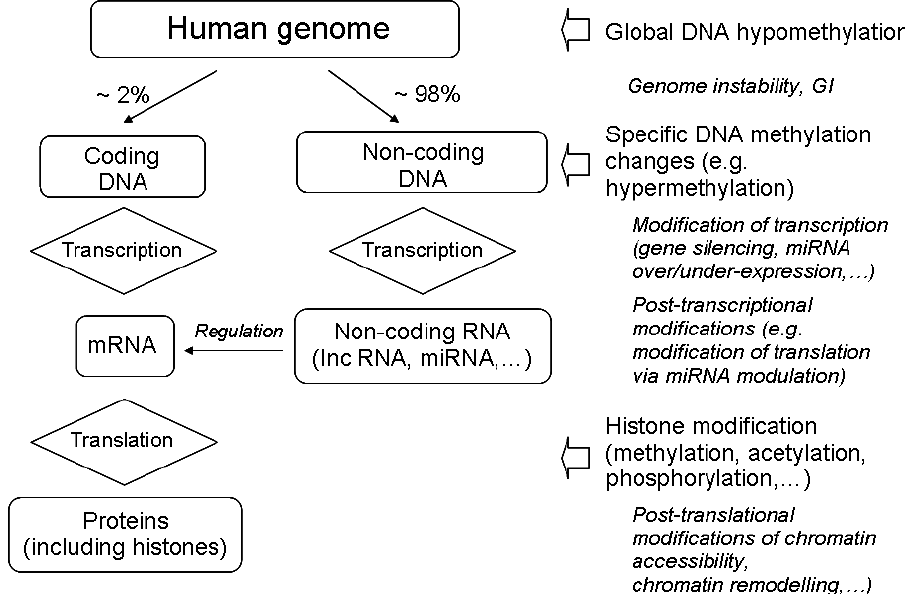
Figure 1. Epigenetic mechanisms involve different levels of gene expression (transcriptional, post-transcriptional, and post-translational). Only a small fraction of the human genome (2% or even less) accounts for protein-coding genes while the majority is associated with non-coding sequences, notably non-coding RNA genes. Of the non-coding DNA, only the regulatory part, giving rise to non-coding RNAs, is considered here. Epigenetic mechanisms can involve both protein-coding and non-coding RNA genes, with interplay between DNA methylation, histone modification and miRNA expression.